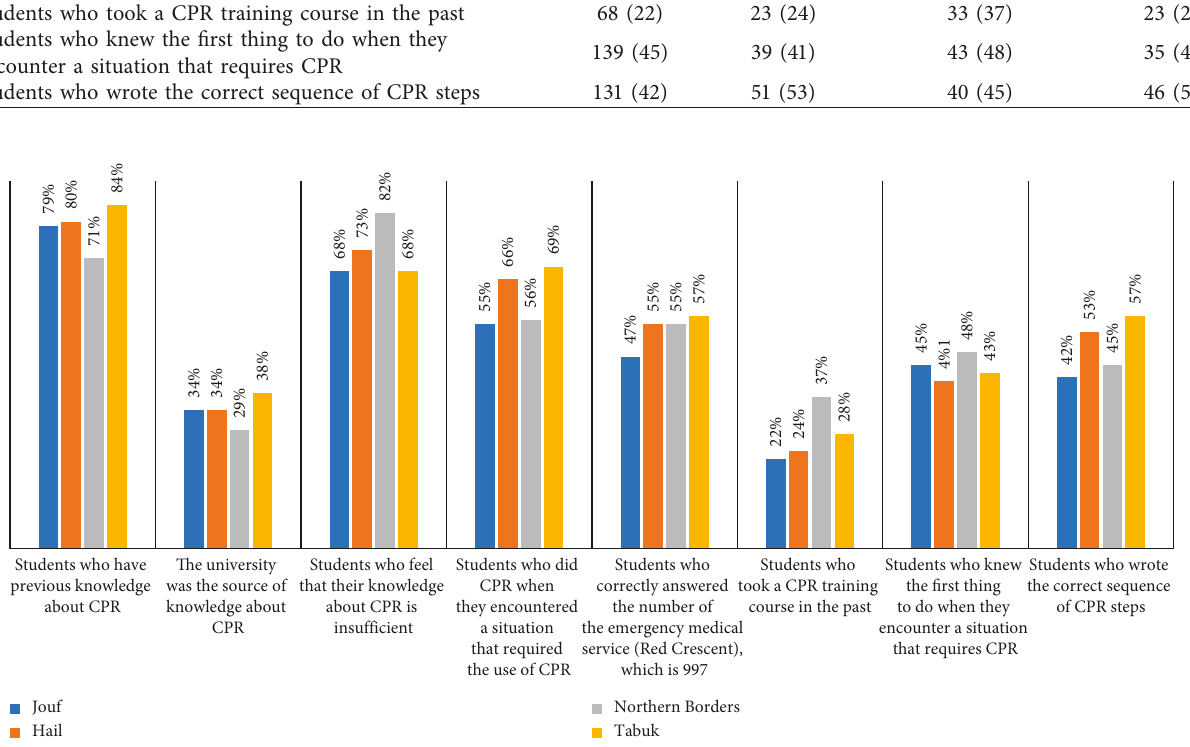
Figure 8: Comparison between health-related colleges of each university.